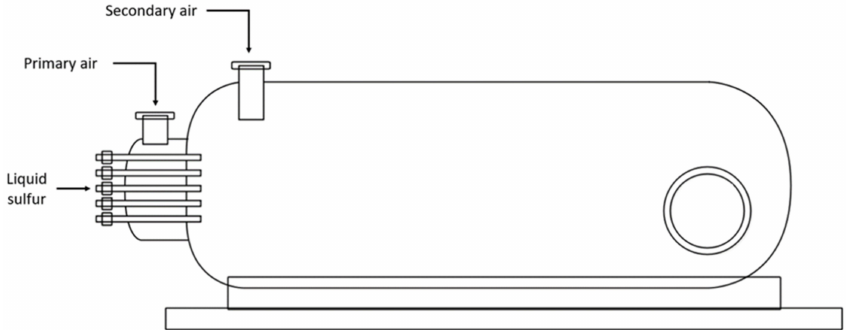
Figure 1. Industrial sulfur combustion